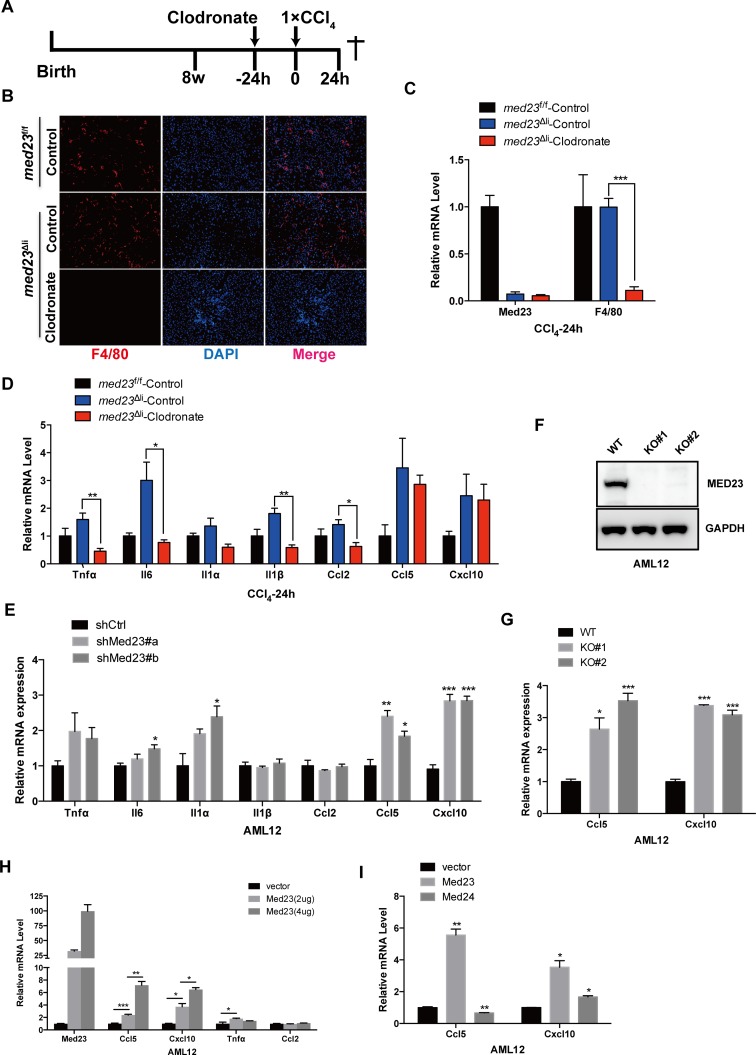
Increased Ccl5 and Cxcl10 expression directly in hepatocytes with Med23 deletion in vivo and in vitro.(A) Strategy to delete macrophages in liver and administrate with acute CCl4 for 24 hours. (B) Representative views of F4/80 staining in the liver sections of med23f/f and med23Δli mice after tail intravenous injection of control liposome and clodronate liposome and then CCl4 administration for 24 hours. (C) qRT-PCR analysis of Med23 and F4/80 in whole-liver extracts of med23f/f and med23Δli mice (med23f/f-Control, n = 4; med23Δli-Control, n = 4; med23Δli-Clodronate, n = 7). (D, E) qRT-PCR analysis of proinflammatory cytokines and chemokines in whole-liver extracts of med23f/f and med23Δli mice (med23f/f-Control, n = 4; med23Δli-Control, n = 4; med23Δli-Clodronate, n = 7) (D) and AML12 cells with Med23 knockdown (n = 3 per group) (E). (F) The protein level of MED23 was analyzed by western blotting in AML12 cells after CRISPR/Cas9 mediated Med23 KO. GAPDH was used as a loading control. (G) qRT-PCR analysis of Ccl5 and Cxcl10 in Med23 KO AML12 cells (n = 3 per group). (H, I) qRT-PCR analysis of proinflammatory cytokines and chemokines in AML12 cells after transient transfection (n = 3 per group). Data are presented as means ± SEM. *P < 0.05, **P < 0.01, ***P < 0.001. For underlying data, see S1 Data file. AML12, alpha mouse liver 12; Ccl, C-C motif chemokine ligand; CCl4, carbon tetrachloride; Cxcl, C-X-C motif chemokine ligand; GAPDH, glyceraldehyde 3-phosphate dehydrogenase; Il, interleukin; KO, knockout; MED23, Mediator complex subunit 23; med23Δli, liver-specific knockout of Med23; med23f/f, med23-floxed; qRT-PCR, quantitative real-time PCR; shCtrl, negative control vector containing scrambled shRNA; shMed23, shRNA against Med23; Tnfα, tumor necrosis factor alpha; WT, wild-type.